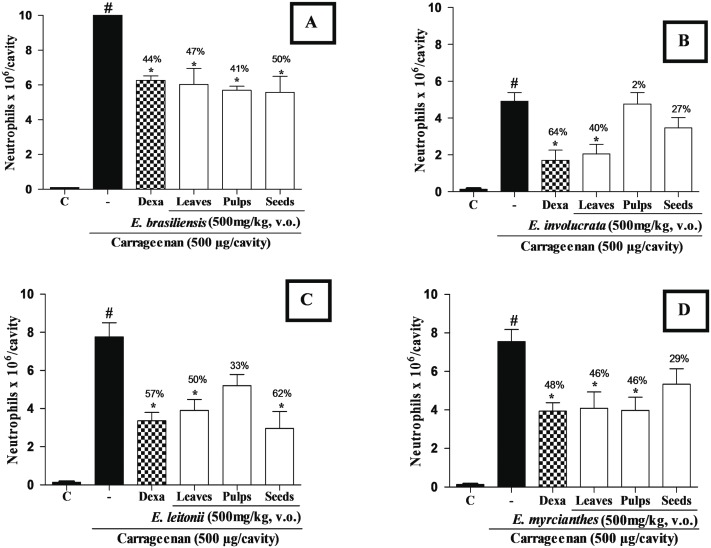
Effect of the oral administration of ethanolic extracts of leaves, seeds, and pulp of four Brazilian native fruit species on the inhibition of neutrophil migration to the peritoneal cavity of mice treated with 500 mg/kg.(A) Eugenia brasiliensis. (B) Eugenia involucrata. (C) Eugenia leitonii. (D) Eugenia myrcianthes. C: control treated with vehicle; –: carrageenan (500 μg/cavity); Dexa: dexamethasone (2 mg/kg). Data are expressed as mean ± standard deviation of the mean; n = 6. Symbols indicate statistical differences (p < 0.05, Tukey’s test): # p < 0.05 compared with the control group; * p < 0.05 compared with the carrageenan group. The symbol % indicates decrease in the number of neutrophils in the peritoneal cavity.